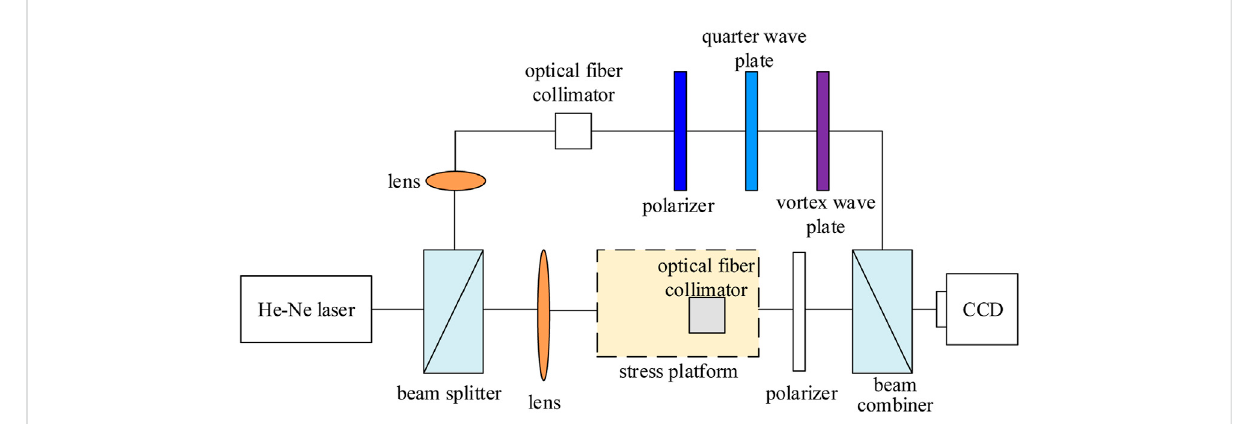
FIGURE 1 Fiber optic stress sensing system structure.